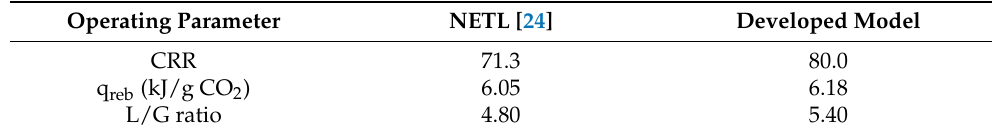
Table 1. Validation of the developed CO 2 capture model.